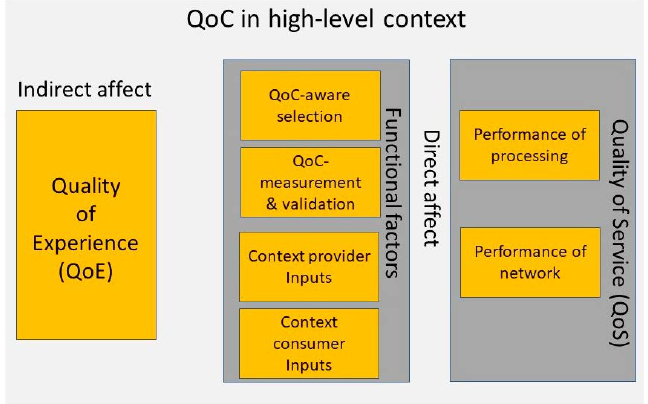
Figure 1. Various factors that affect the QoC in a high-level context. Each block describes a factor. Underlying blocks describe the factors that affect the overarching block’s factor.